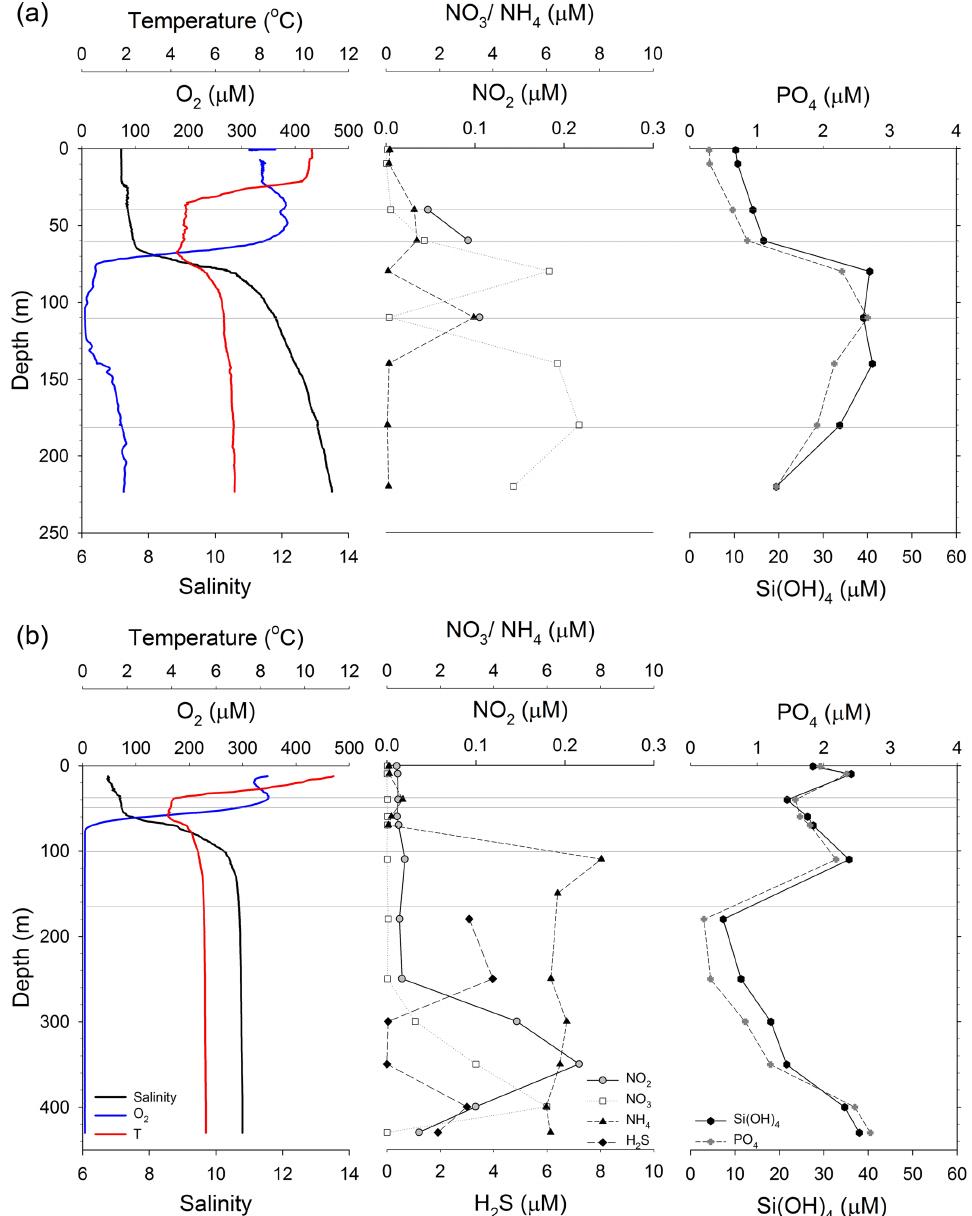
Figure 2. Water column profiles at the location of the sediment trap deployments in (a) GB, and (b) LD. Left panels: oxygen (blue), temperature (red) and salinity (black). Middle panels: nitrate (NO 3 , white squares), nitrite (NO 2 , grey circles), ammonium (NH 4 , black triangles) and hydrogen sulfide (H 2 S, black diamonds). Right panels: phosphate (PO 4 , grey diamond) and silicate (Si ( OH ) 4 , black circles). Grey lines indicate the depths at which we deployed sediment